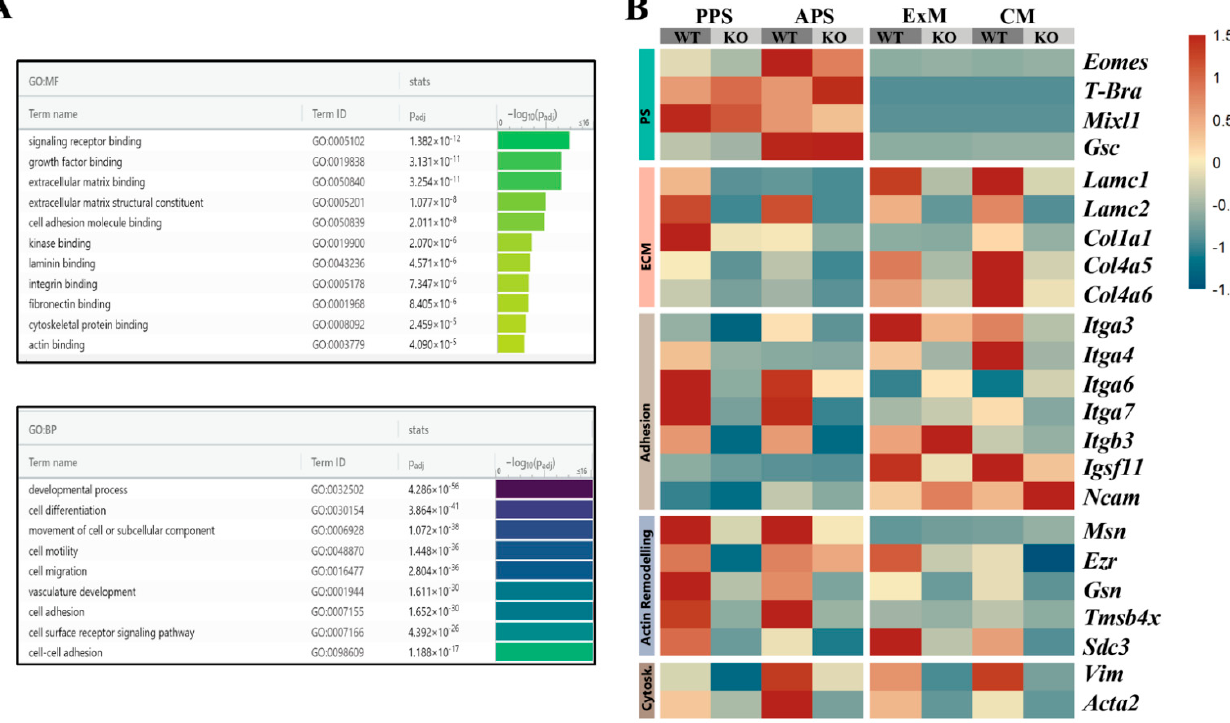
Figure 6. PGR influences cell-ECM, cell-cell interactions and cytoskeletal remodeling of mesoderm progenitors. ( A ) GO-term enrichment analysis of genes differentially expressed in WT and Pgr-KO PPS displays significant overrepresentation of terms associated with ECM interactions, cell adhe- sion, and cytoskeletal protein binding (Fisher’s exact test with Bonferroni correction). ( B ) Heatmap indicating downregulation of Laminins, Collagens, and actin remodeling transcripts in APS and PPS with moderate changes in the PS signature genes. In ExM and CM, adhesion and ECM genes are downregulated in Pgr-KO , with the exception of Itgb3 , which is specifically upregulated in the ExM and Ncam 1, which is upregulated in CM. ( C ) PGR-KO cells show altered expression of genes related to cellular adhesion, cytoskeleton remodeling, and ECM composition. Changes in the cellu- lar interactions with the direct environment alter the differentiation program and affect the balanced production of mesoderm types.